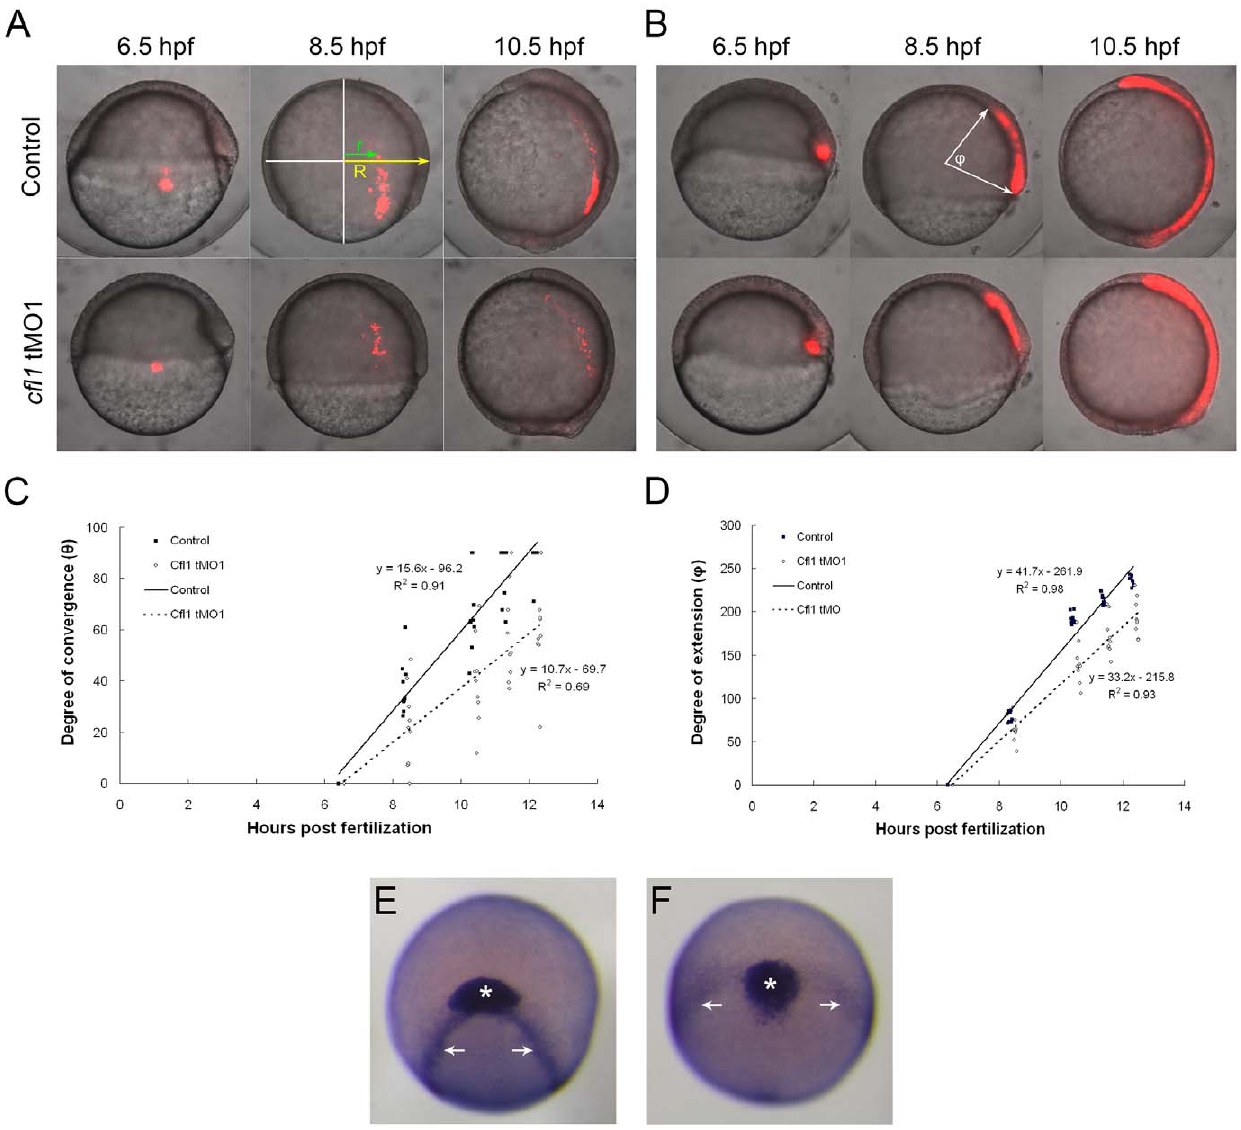
Figure 8. Knockdown of cfl1 causes convergent and extension defects. (A, B) Embryos were injected with Q-rhodamine with or without cfl1 tMO 1 and incubated in the dark. Cells of the lateral (A) and dorsal blastomere margins (B) are marked as shown in red fluorescence at the shield stage and observed until 10.5 hpf. Representative photographs taken at 6.5, 8.5 and 10.5 hpf for both the untreated control and cfl1 MO-injected embryos are shown. (C) As shown in the panel A with an 8.5-hpf control embryo, the radius of the embryo (R) and the migration distance of the labeled cells (r) were measured. The degree of convergence ( h ) was calculated by applying the following equation: h = sin 2 1 (r/R), and then plotted against the stage of the embryo in hpf. (D) As shown in panel B with an 8.5-hpf control embryo, the angle ( w ) between the two arrows of the anterior and posterior ends of the marked axial mesoendoderm connecting the center of the embryo was measured in each embryo to estimate the degree of extension. The degree of extension ( w ) was then plotted against the stage of the embryo. (E, F) WISH against cstl1b (expressed in the prechordal plate as indicated by asterisks) and dlx3b (expressed in paraxial mesoderm as indicated by arrows) of bud-stage zebrafish embryos was performed. Representative photographs in frontal view are shown for an untreated (E) and a cfl1 tMO 1 -injected embryo (F).